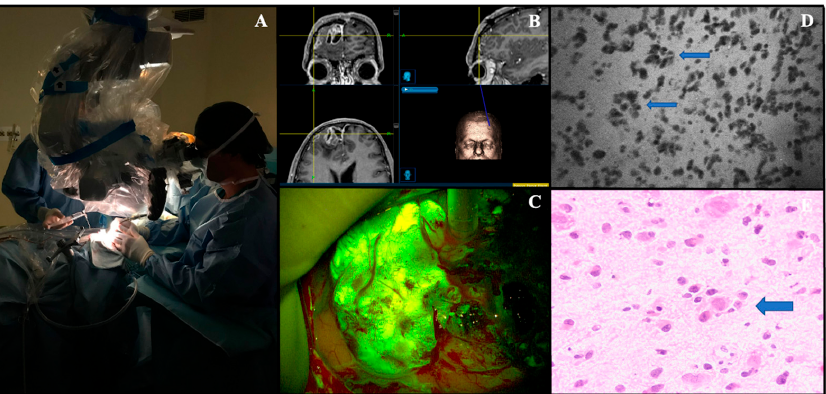
Figure 2. In vivo Convivo case (Besta Neurological Institute, Milan, Italy). ( A ). the confocal probe is dressed with its appropriate sterile sheath and used directly upon cerebral surface. ( B ). Preoperative magnetic resonance with contrast administration images loaded on the neuronavigation system (Stealth S8-Medtronic) of a right frontal parasagittal anaplastic oligodendroglioma, IDH mutant (WHO grade III). ( C ). Intraoperative view of fluorescein-guided removal of the tumor under YEL- LOW560 filter activation on Pentero microscope (Carl Zeiss Meditec). ( D ) . Convivo in vivo image taken at the center of the tumor showing tumor cells along with typical perineural satellitosis (small arrows), that can be easily found on relative histopathological image as well (H-E, big arrow, ( E